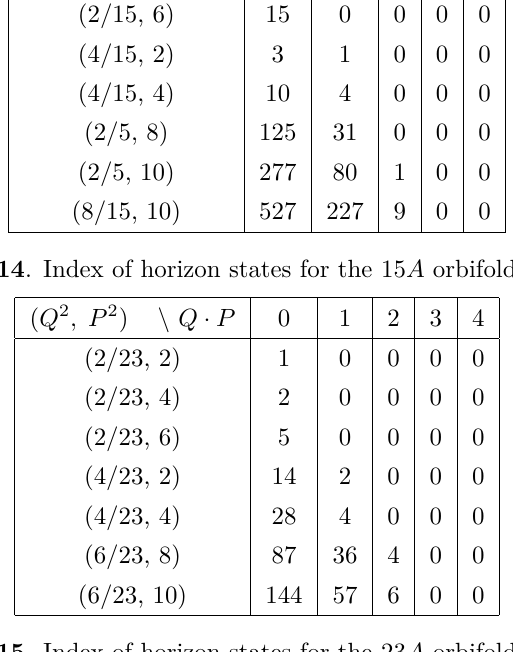
Table 15 . Index of horizon states for the 23 A orbifold of K 3